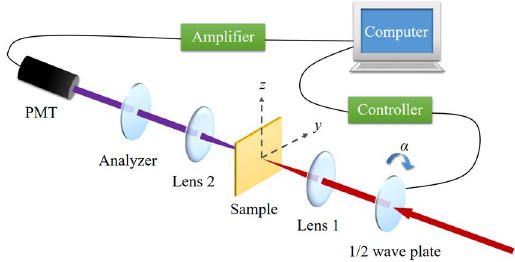
Figure 1. The experimental schematic for SHG transmission measurement. α stands for the angle between directions of the incident light polarization and the y -axis, which is modulated by a half-wave ( λ /2) plate assembled on a stepping motor controlled by a computer. Lens 1 is the focusing lens, while lens 2 is for collimating. The laboratory coordinate system is established as shown which is not sample